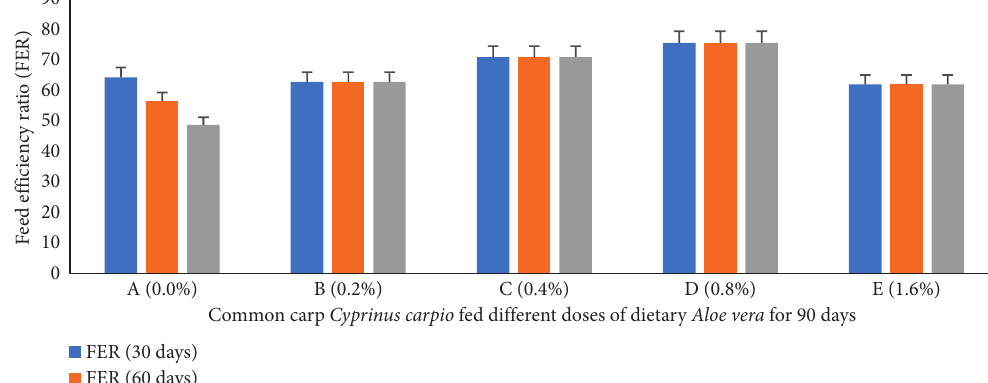
Figure 4: Cyprinus carpio fed varied doses of Aloe vera and feed efficiency ratio (FER) studied after 90days of feeding